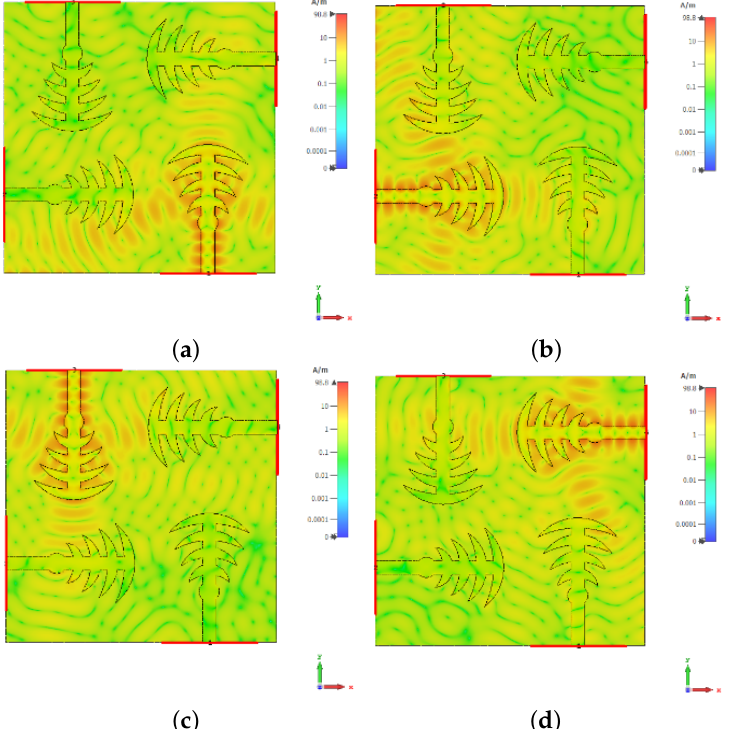
Figure 7. MIMO antenna system current distribution at 28 GHz for ( a ) port 1, ( b ) port 2, ( c ) port 3, and ( d ) port